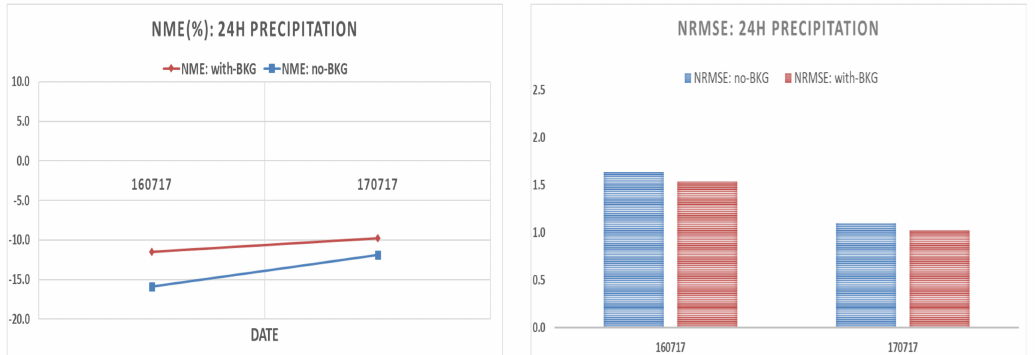
Figure 7. NME% ( left , y axis) and NRMSE ( right , y axis) with (red) and without (blue) the use of H-SAF background field after the application of LOOCV for 16–17 July